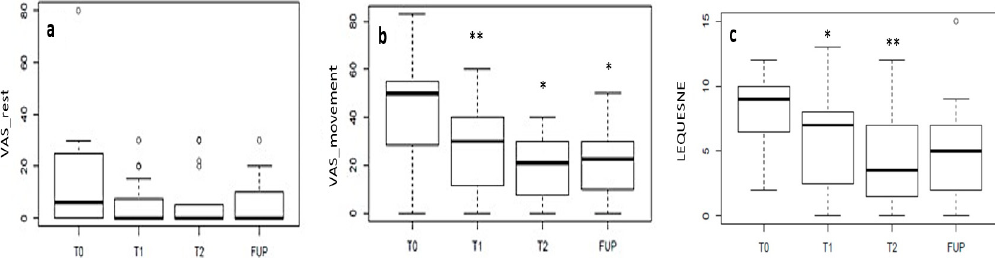
Figure 5. VAS at rest ( a ), when moving ( b ) and Lequesne ( c ) scores. Median VAS at rest did not change significantly after the CG injections. Median VAS when moving decreased significantly after the first injection (T1 vs. baseline, p = 0.01) but did not decrease further after the second one (T2); the median Lequesne decreased significantly after the first injection (T1 vs. baseline, p = 0.03), did not decrease further after the second injection and was stable at the 6-month follow-up.